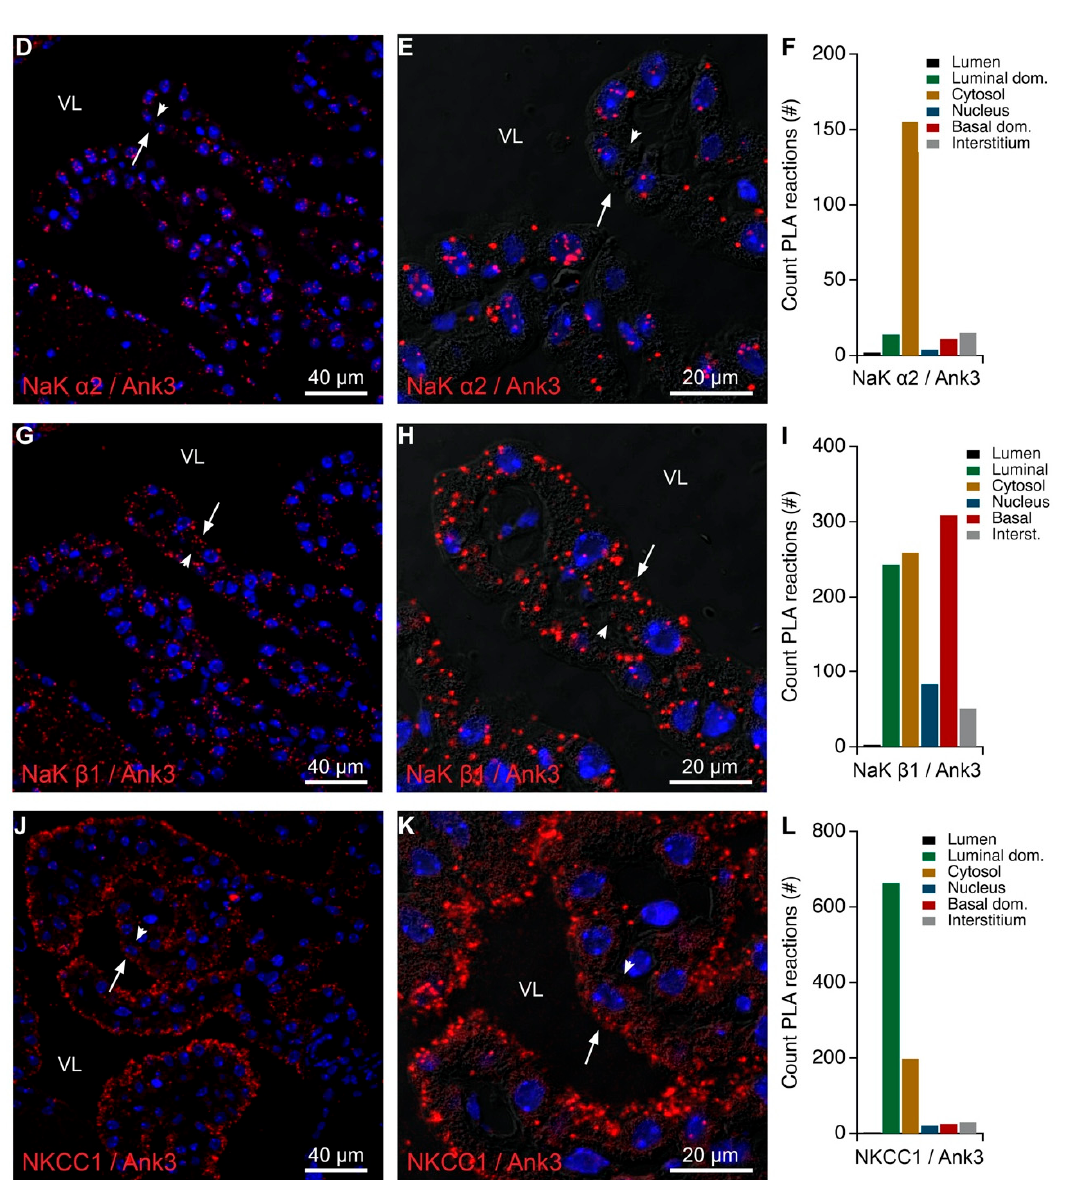
Figure 10. Colocalization of ankyrin-3 and Na,K-ATPase subunits or NKCC1 by PLA. ( A ) Representative immunofluores- cence image of PLA products (red) using anti-ankyrin-3 (Ank3) and anti-Na,K-ATPase α 1 (NaK α 1) antibodies and cell nucleus counterstain (blue) at low magnification. ( B ) Higher magnification micrograph of the same structure overlaid on the corresponding DIC image. ( C ) Bar graph representing the count of PLA reactions in the indicated image areas. ( D ) Representative immunofluorescence image of similar PLA products (red) using a separate set of anti-ankyrin-3 (Ank3) and anti-Na,K-ATPase α 2 (NaK α 2) antibodies and cell nucleus counterstain (blue) at low magnification. ( E ) Higher magnification micrograph of the same structure overlaid on the corresponding DIC image. ( F ) Bar graph representing the count of PLA reactions in the indicated image areas. ( G ) Representative immunofluorescence image of similar PLA products (red) using anti-ankyrin-3 (Ank3) and anti-Na,K-ATPase β 1 (NaK β 1) antibodies and cell nucleus counterstain (blue) at low magnification. ( H ) Higher magnification micrograph of the same structure overlaid on the corresponding DIC image. ( I ) Bar graph representing the count of PLA reactions in the indicated image areas. ( J ) Representative immunofluorescence image of PLA products (red) using anti-ankyrin-3 (Ank3) and anti-NKCC1 (NKCC1) antibodies and cell nucleus counterstain (blue) at low magnification. ( K ) Higher magnification micrograph of the same structure overlaid on the corresponding DIC image. ( L ) Bar graph representing the count of PLA reactions in the indicated image areas. Arrows indicate luminal surfaces, while arrowheads mark basolateral surfaces. VL denotes the fourth ventricle